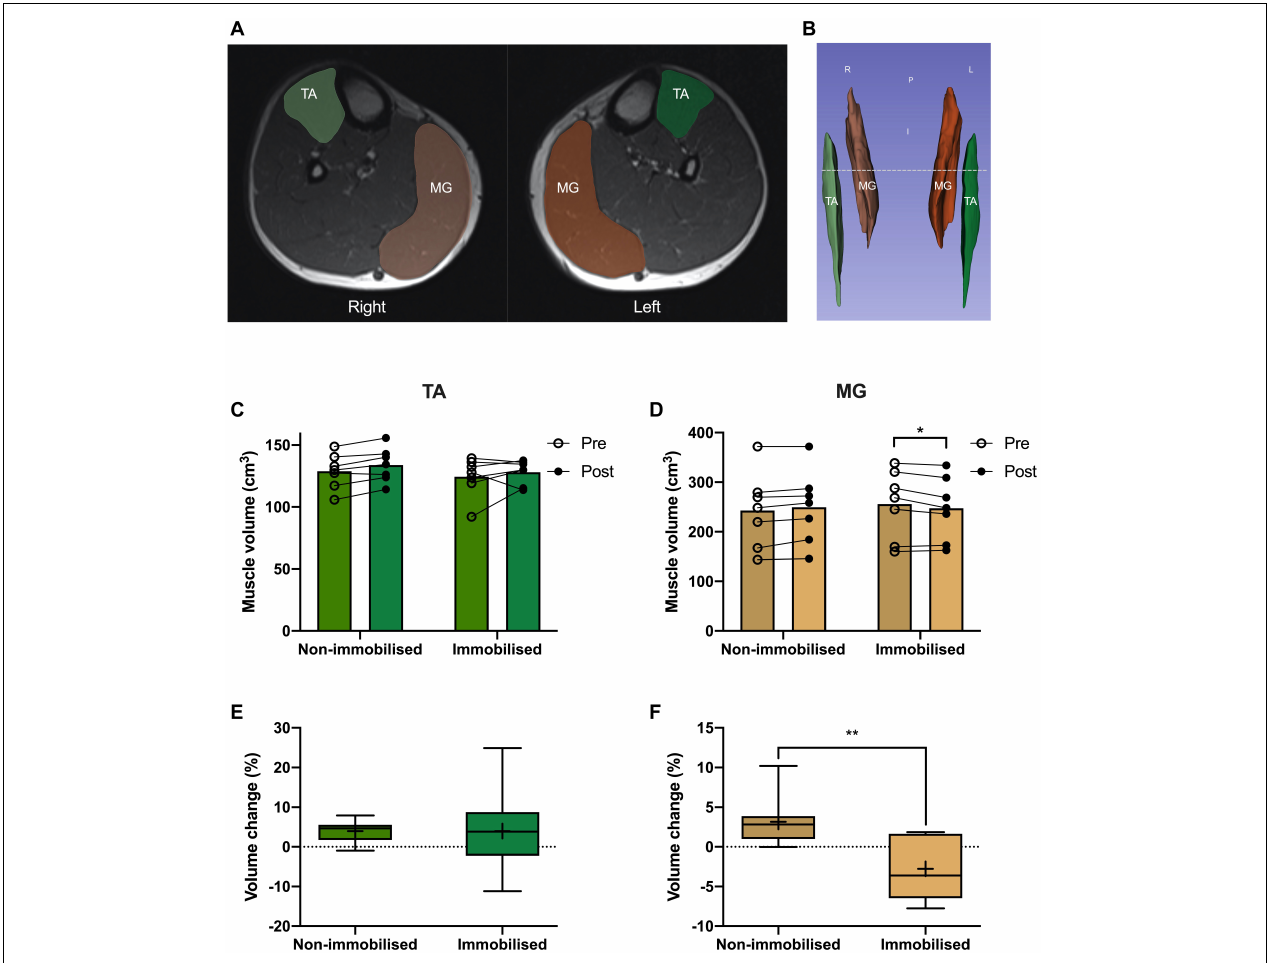
FIGURE 4 | (A) MRI image of tibialis anterior (TA; green) and medial gastrocnemius (MG; orange), and representative 3D segmentation volume analysis (B) , dotted line denotes MRI slice. Pre and post 15 day unilateral leg immobilisation TA (C) and MG (D) volume in non-immobilised and immobilised legs. Muscle volume changes compared to baseline values in TA (E) and MG (F) . Mean values are denoted as +, with box margins the 25th and 75th percentile and whiskers min to max values. * p < 0.05, ** p < 0.01 between indicated groups. Pre and post analysis measured by 2-way ANOVA, volume change by paired t